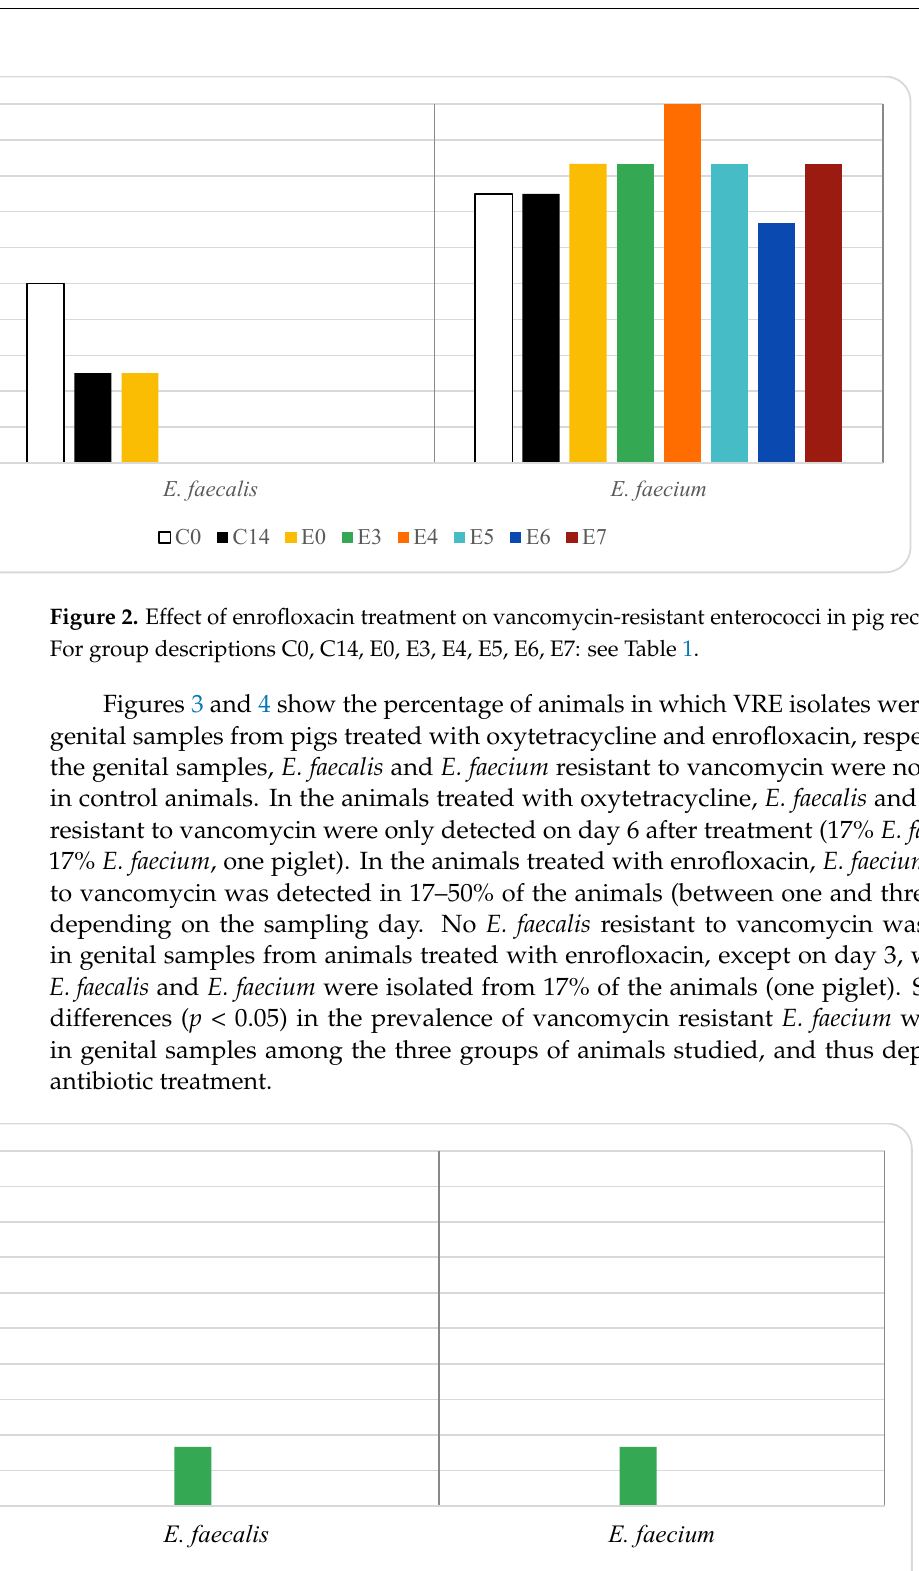
Figure 1. Effect of oxytetracycline treatment on vancomycin-resistant enterococci in pig rectal sam- ples. For group descriptions C0, C14, T0, T6, T13, T15, T17 and T19: see Table 1.